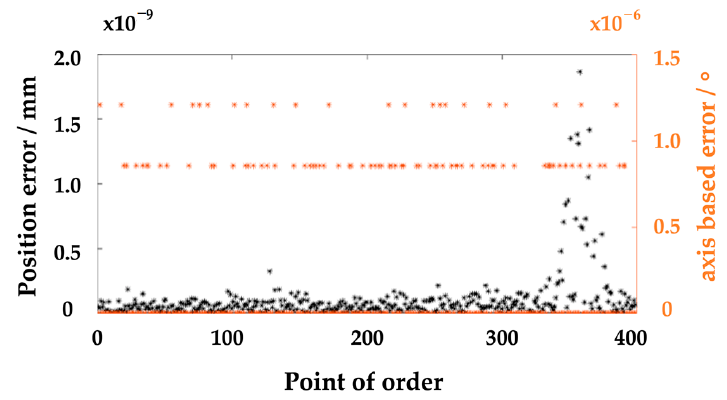
Figure 8. Inverse kinematics via the closed-form solution.